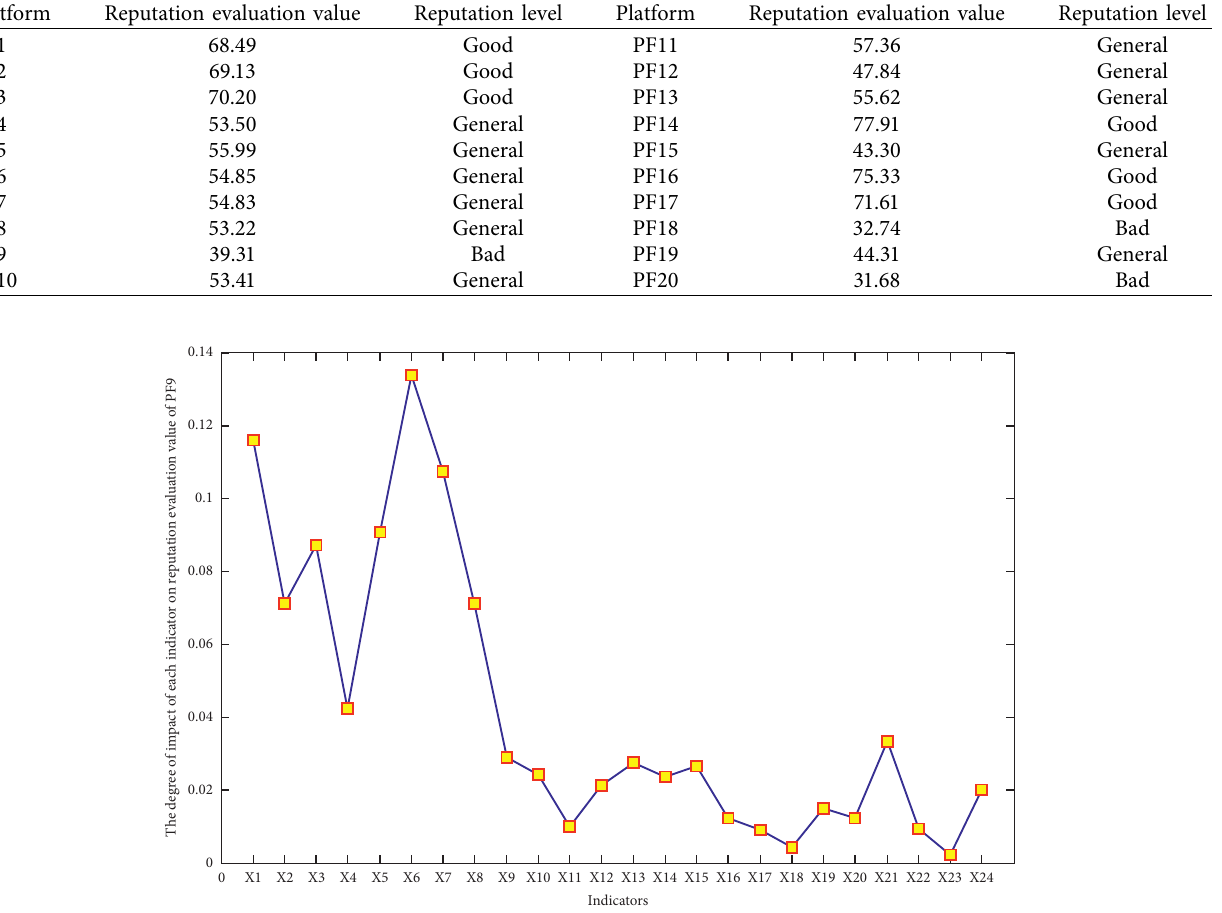
Table 19: The reputation level of IFPs.